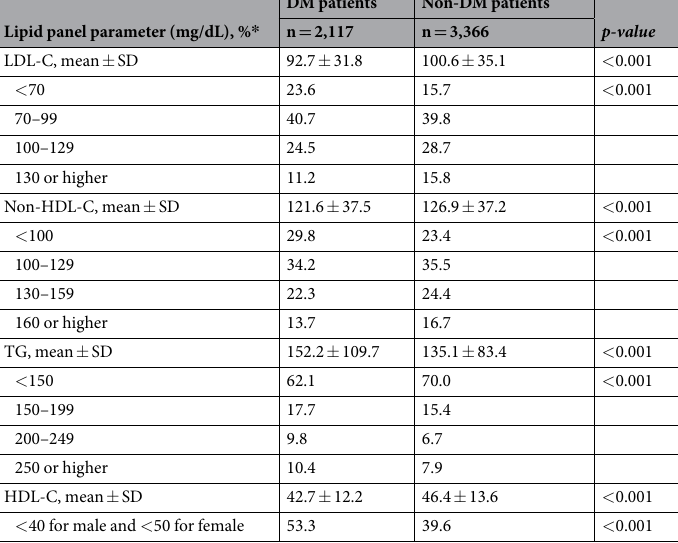
Table 2. Lipid profile of the enrolled diabetic and nondiabetic ASCVD patients. * Proportions were calculated based on the number of patients without missing value of that lipid